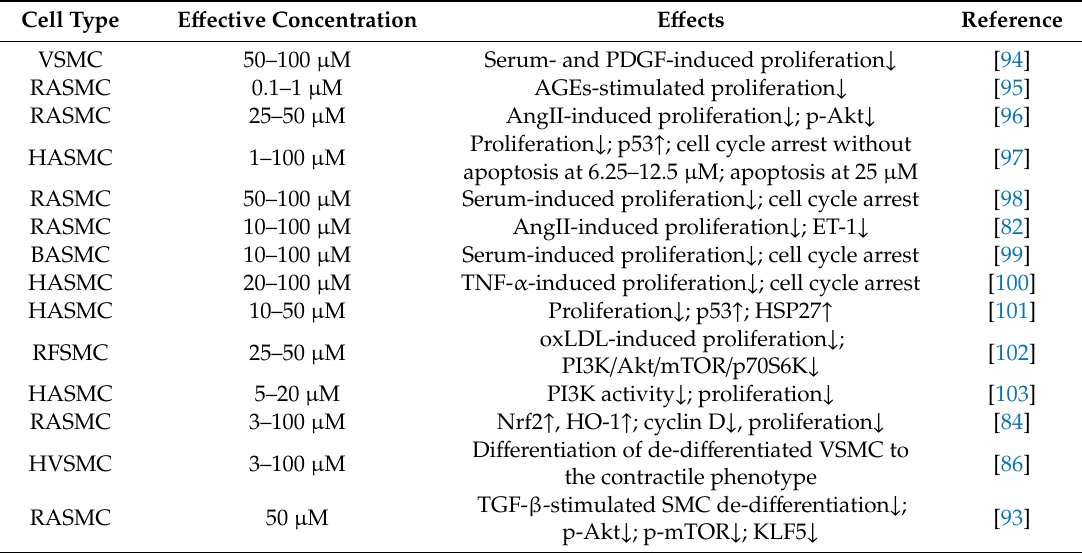
Table 4. E ff ects of resveratrol in vascular smooth muscle cells